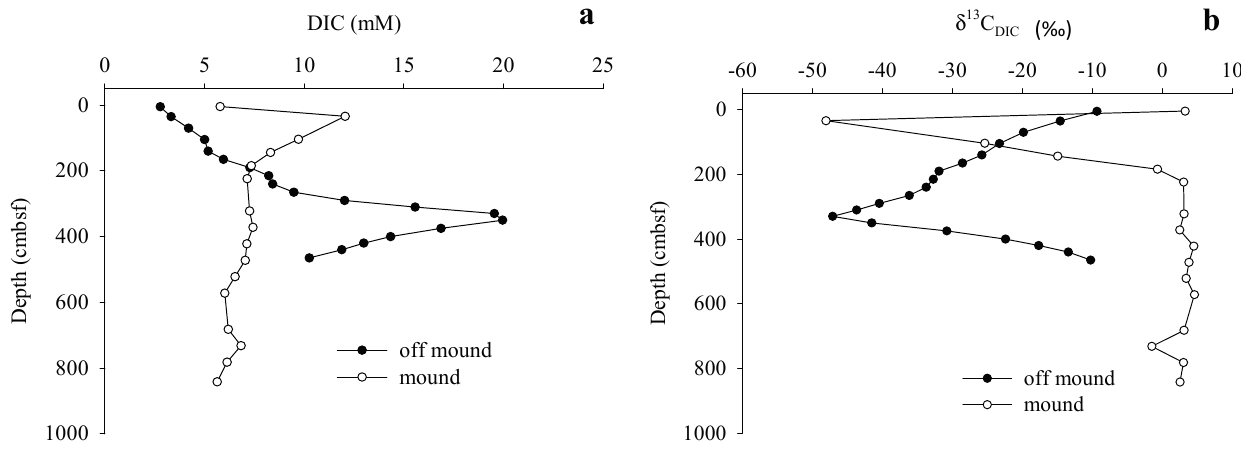
Figure 6. ( a ) Sediment pore water dissolved inorganic carbon (DIC) concentrations; and ( b ) δ 13 C DIC values measured on-mound and